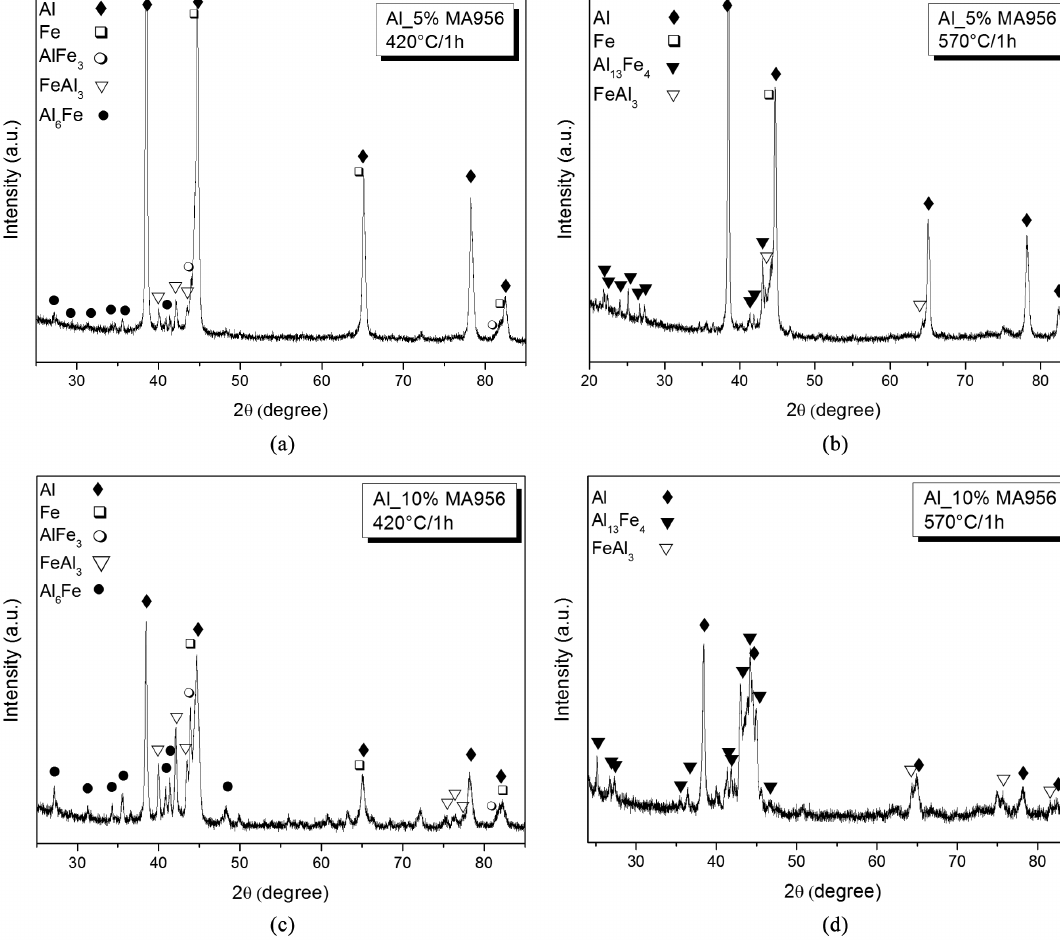
Figure 7. XRD patterns of composite samples after milling for 50 h. (a) Al_5 vol.% MA9556 after heat treatment at 420 °C/1 h; (b) Al_5 vol.% MA9556 after heat treatment at 570 °C/1 h; (c) Al_10 vol.% MA9556 after heat treatment at 420 °C/1 h and (d) Al_10 vol.% MA9556 after heat treatment at 570 °C/1